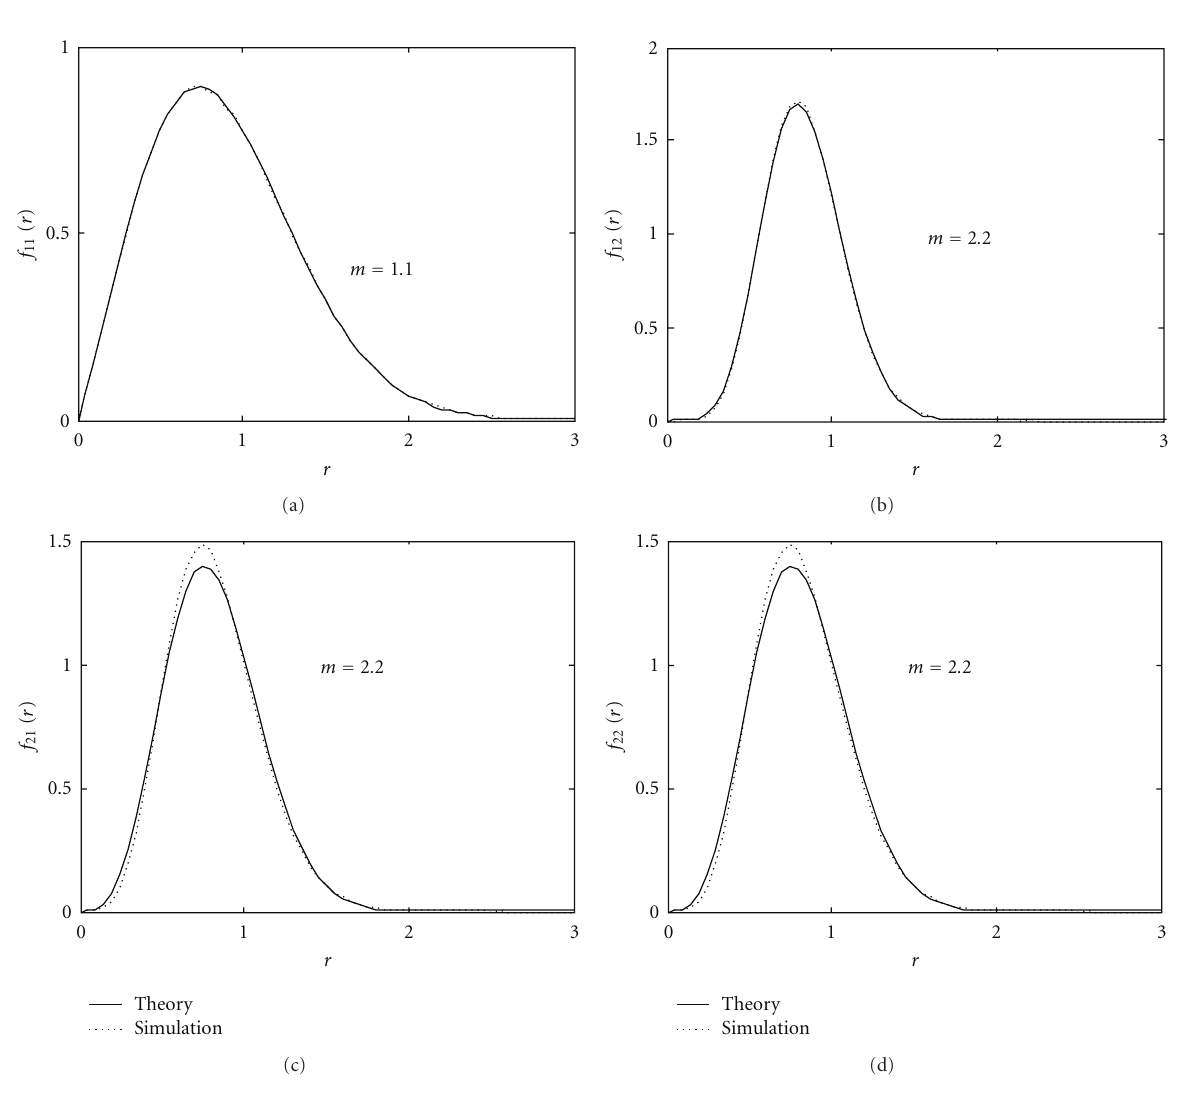
Figure 7: The PDFs of simulated subchannel fading